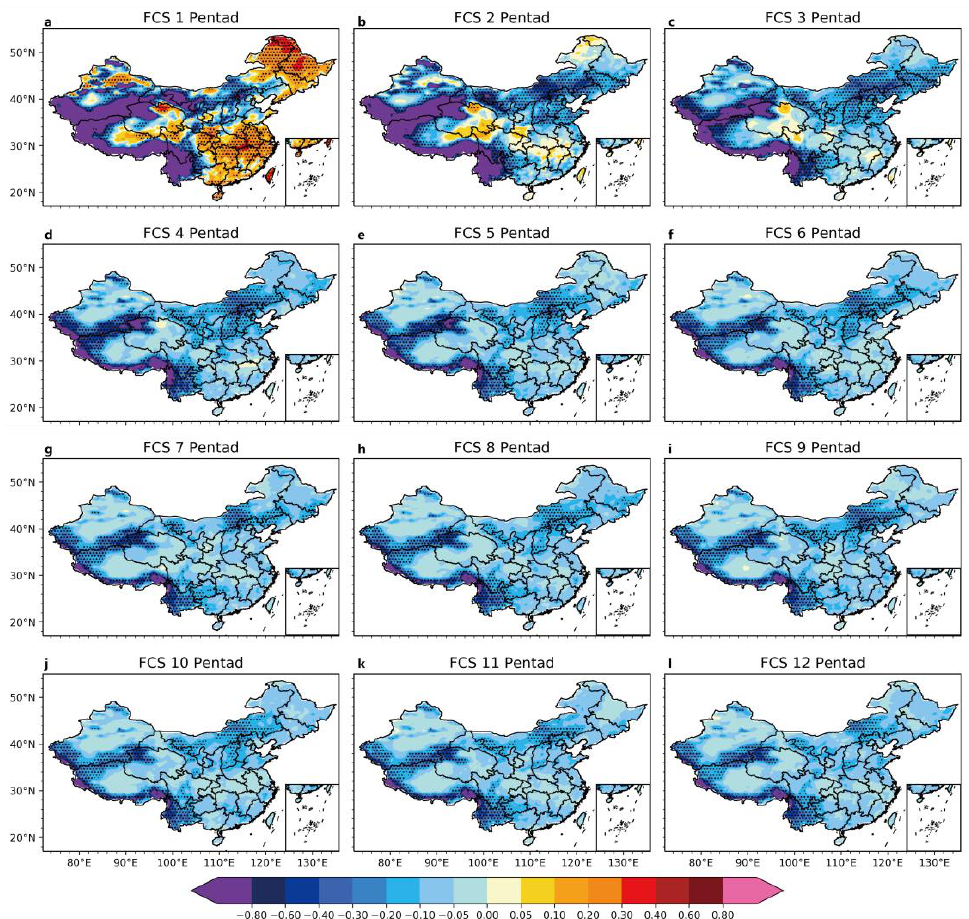
Figure 9. Spatial pattern of annual average MSSS for the 1–12 pentad ( a – l , respectively) precipitation forecast of the FGOALS-f2 model from 2000 to 2018. The dotted regions are where the MSSS passed the 95% significance test.